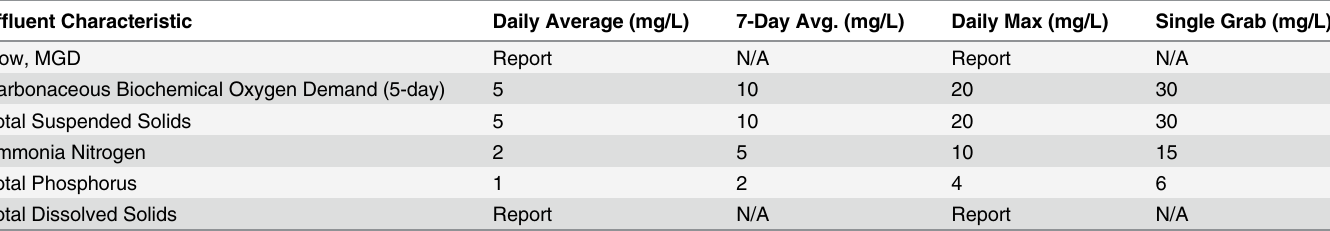
Table 1. Discharge limitations of effluent from the Wilbarger Wastewater Treatment Facility at 0.5 million gallons per day (MGD) discharge stage.